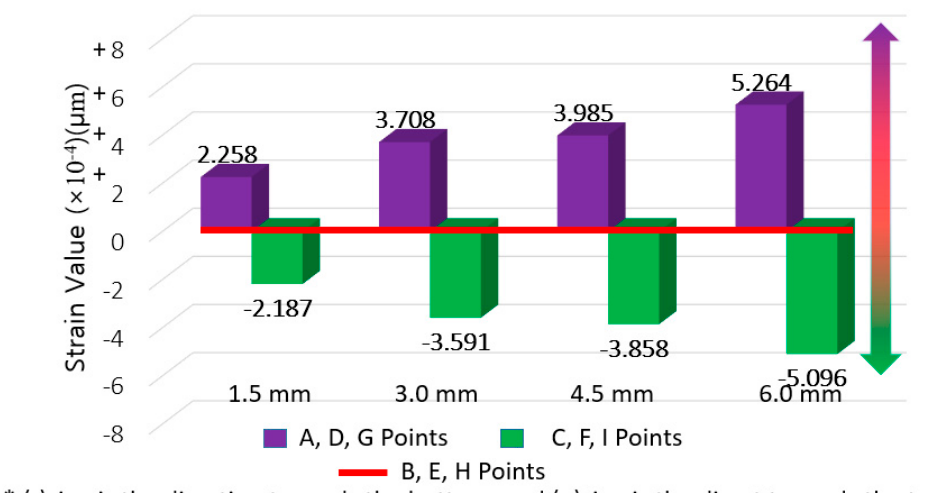
Figure 10. PUC strain difference results (for deriving strain concentration ratio).